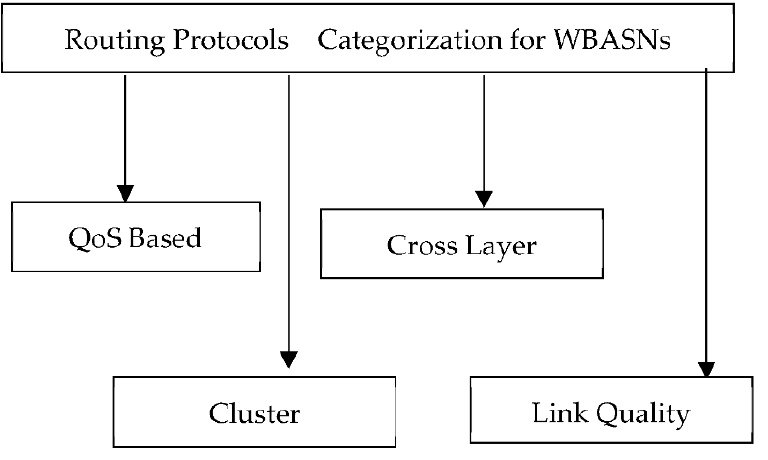
Figure 8. Categorisation of WBASN routing